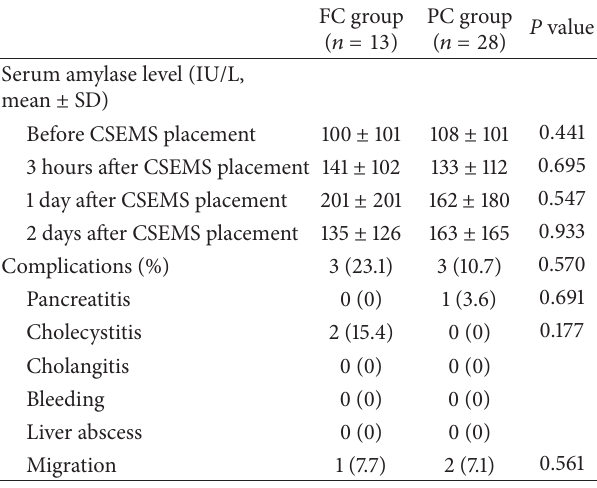
Table 3: Comparison of complications between the FC and PC groups within the non-EST